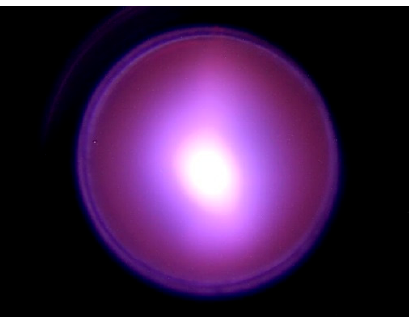
Figure 3. Image of video camera connected to a telescope looking into the gas stripper along the axis. Stripper hole diameter is 16 mm.